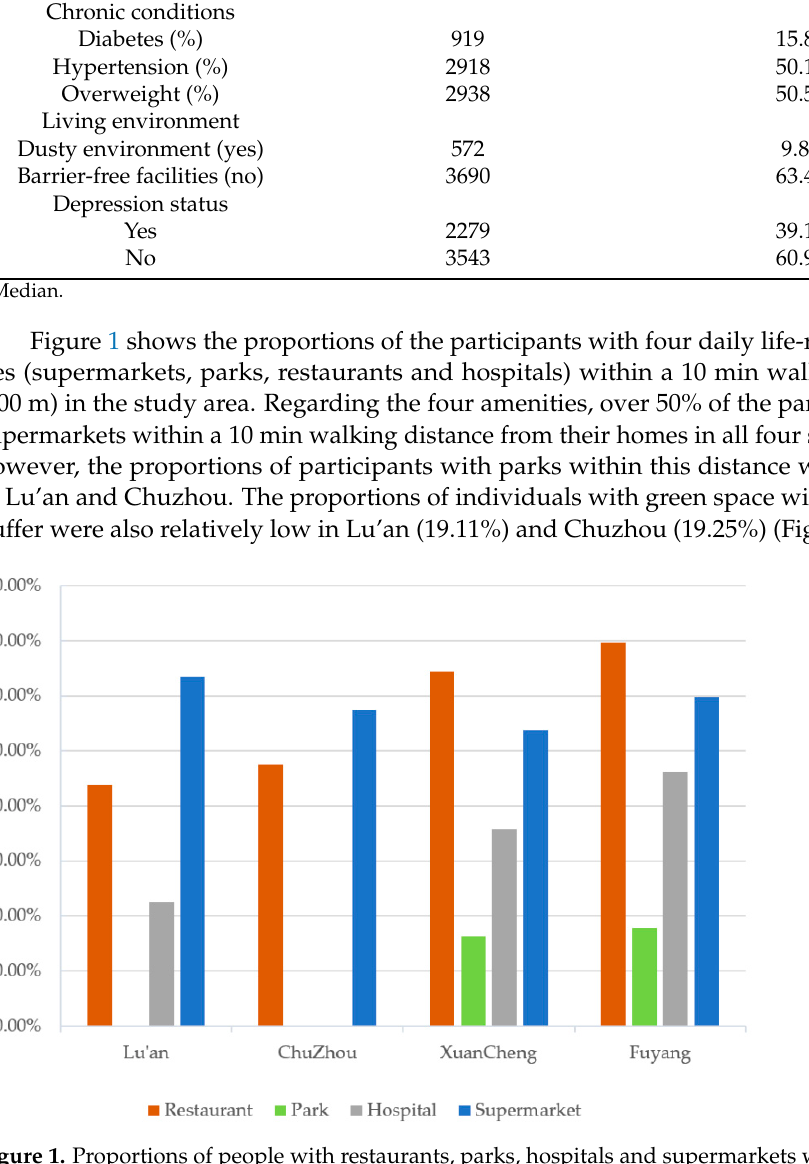
Figure 2. Proportions of the people with and without green space within an 800 m buffer by city (%). The associations between living and built environments and depression symptoms are shown in Table 2. Participants living in a non-dusty environment had a lower risk of depression (OR = 0.767, 95% CI: 0.630, 0.934), although such association existed only among females (OR = 0.732, 95% CI: 0.560, 0.957) and not males. The participants with no access to barrier-free facilities had a higher risk of depression (OR = 1.251, 95% CI: 1.077, 1.453); barrier-free facilities were not associated with depression status among females. General weak and sex-specific associations between built environments and depression symptoms were detected. Male participants who had a park within a 10 min walking dis- tance had a lower risk of depression (OR = 0.631, 95% CI: 0.412, 0.965). Participants who had a hospital within a 10 min walking distance had an elevated risk of depression (OR =